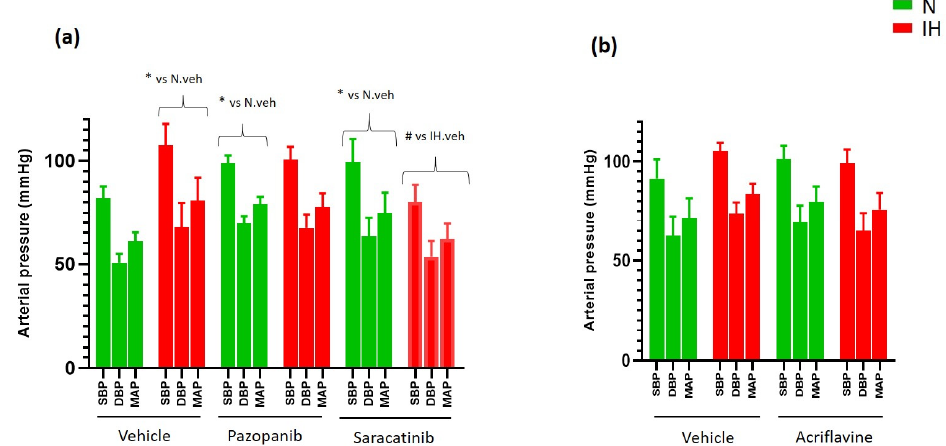
Figure 6. The impact of blocking VE-cadherin cleavage pathways on arterial blood pressures of ApoE-/- mice. ( a ) Inhibiting VEGFR tyr-kinases (by pazopanib) and src-kinases (by saracatinib) prevented the hypertensive effect of IH on arterial blood pressures in ApoE-/- mice exposed to IH for 8 weeks (3-way ANOVA, followed by a Fisher’s LSD test, * p < 0.05 vs. N + vehicle, # p < 0.05 vs. IH + vehicle, n = 5–8). ( b ) IH induced a trend towards elevation of blood pressure, and acriflavine tended to reduce this effect in ApoE-/- mice exposed to IH for 8 weeks (3-way ANOVA, p = 0.17 for the interaction IH × treatment, n = 5–8). Values are mean ± SEM. N: normoxia, IH: intermittent hypoxia. veh: vehicle. SBP = systolic blood pressure, DBP = diastolic blood pressure, MAP =mean blood pressure.